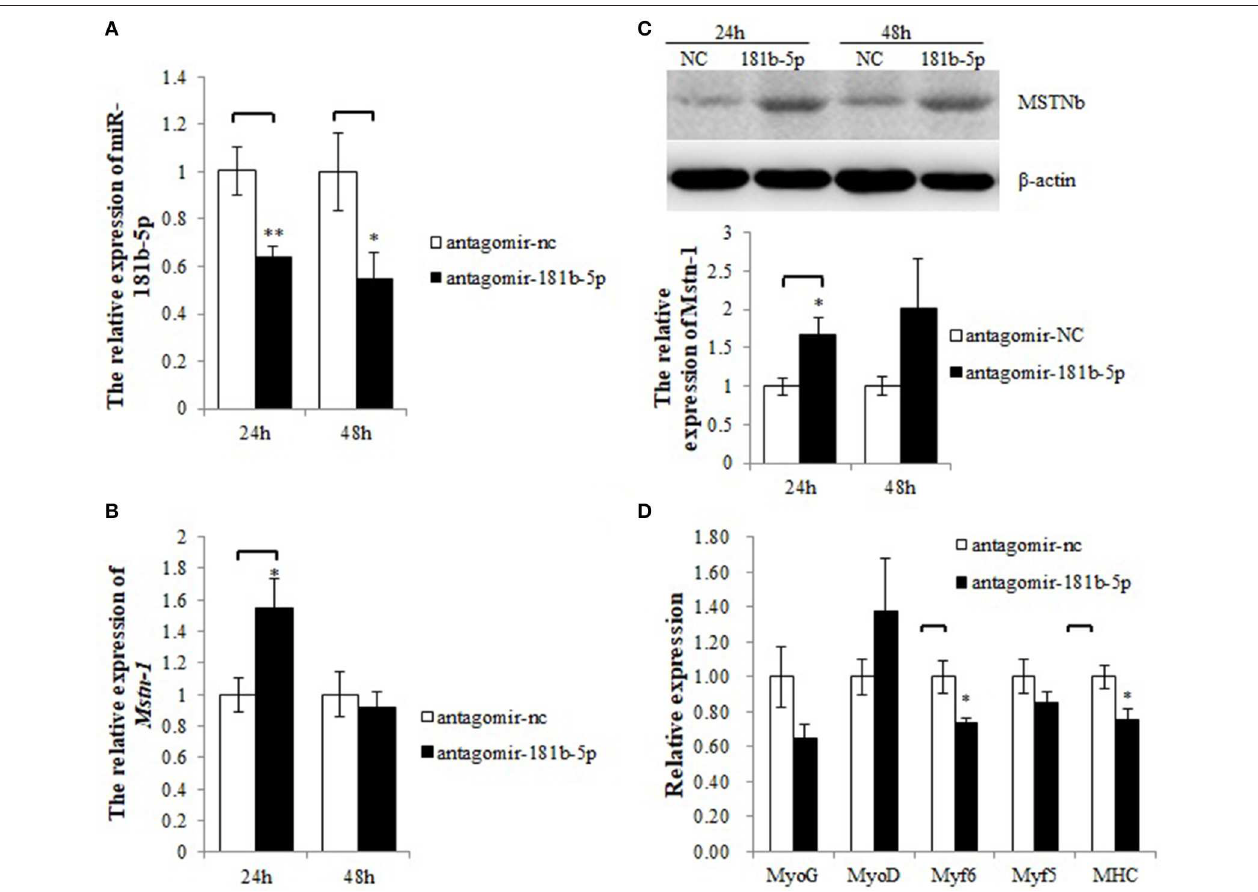
FIGURE 6 | miR-181b-5p silencing influences the expression of Mstnb and its downstream genes. (A) The relative expression of miR-181b-5p. (B) The mRNA expression of Mstnb. (C) The protein level of Mstnb. (D) The mRNA expression of Mstnb downstream genes. Bar: mean ± SEM. * P < 0.05 and ** P < 0.01, One-way ANOVA analysis, n =